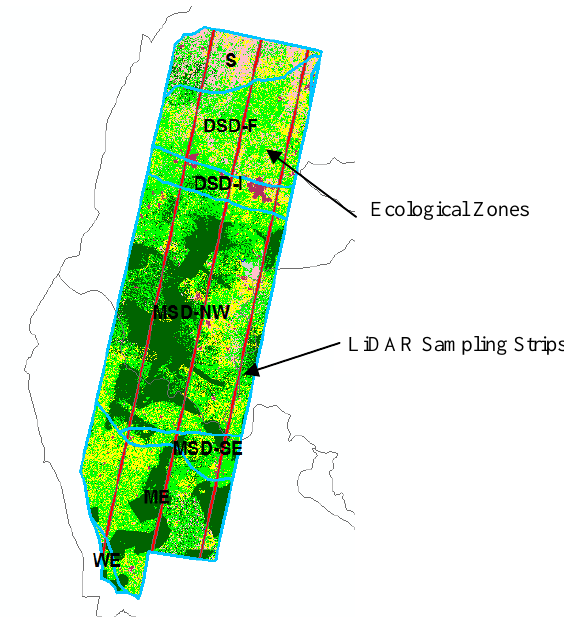
Figure 5. Systematic LiDAR Strip Sample.